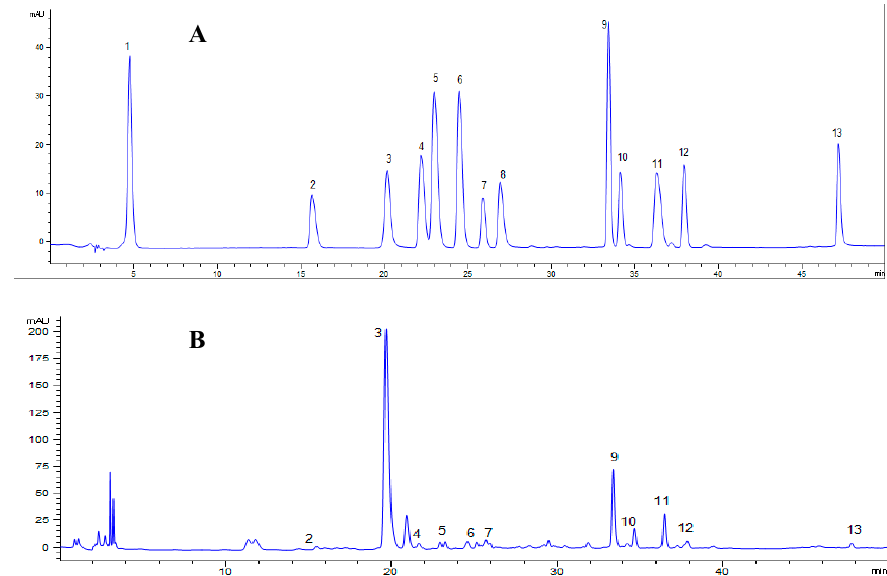
Figure 1. The high-performance liquid chromatography (HPLC) graph of mulberry leaf (Morus multicaulis Roxb) phenolic compounds ( A ) standards, ( B ) mulberry leaf Polyphenols (MLPS). Note: 1. gallic acid, 2. gentisic acid, 3. Chlorogenic acid, 4. vanillic acid, 5. caffeic acid, 6. syringic acid, 7. epicatechin, 8. Ferulic acid 9. rutin, 10. hyperoside, 11. benzoic acid, 12. Astragaloside, 13. Quercetin.